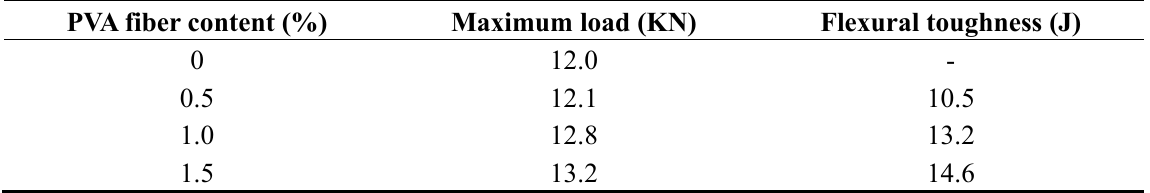
Table 3. Mechanical properties for different fiber contents under the three-point bending test.